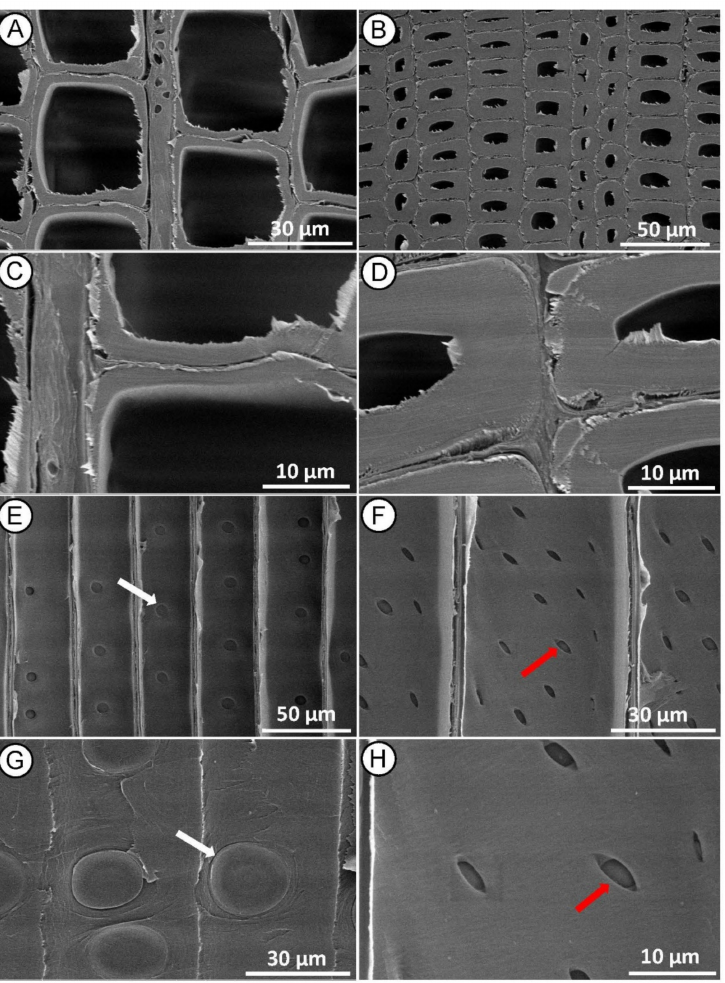
Figure 3. SEM micrographs of control (untreated) Norway spruce. Cross-section showing normal tracheid structure in earlywood ( A , C ) and latewood ( B , D ). Radial section with intact bordered pits on the tracheid walls (( E , G )—white arrows) and undamaged-intact piceoid cross-field pits (( F , H )— red